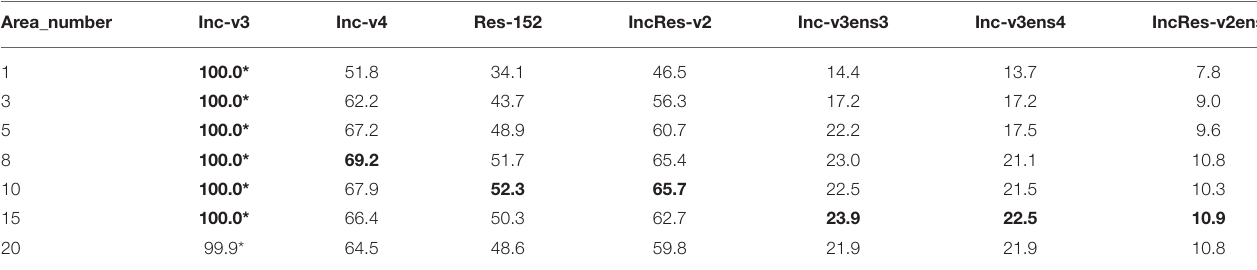
TABLE 1 | The attack success rate (%) of seven models, the leftmost column represents the number of erased matrices whose erased area ratio is 0.1, adversarial examples crafted by REI-FGSM on Inc-v3 model (“*” indicate the white box attack).